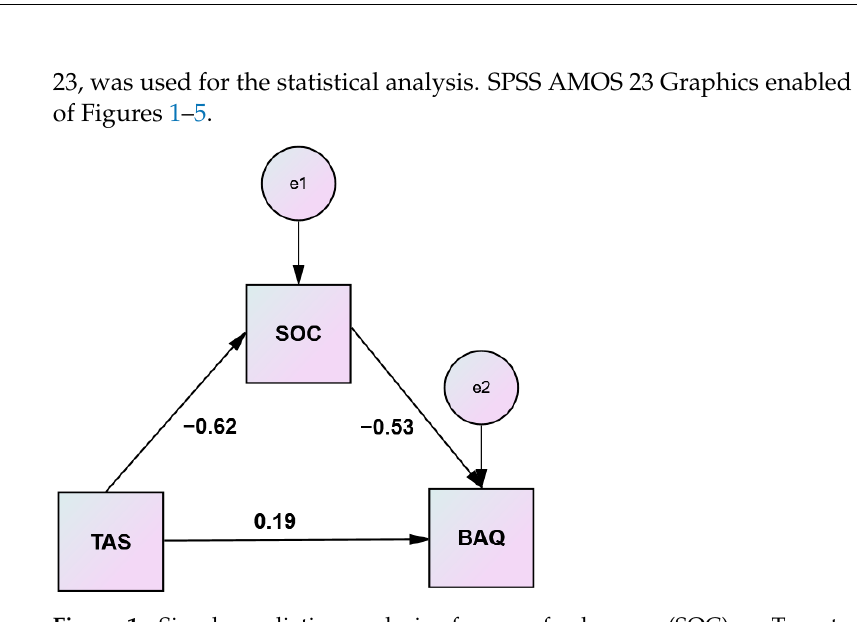
Figure 1. Simple mediation analysis of sense of coherence (SOC) on Toronto alexithymia scale (TAS)–brief aggression questionnaire (BAQ) relationship.